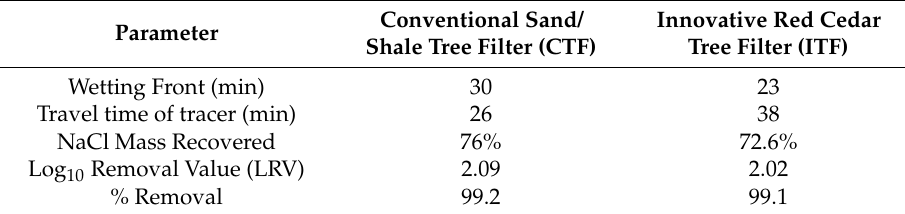
Table 2. Summary of Field Tracer Test results and parameters